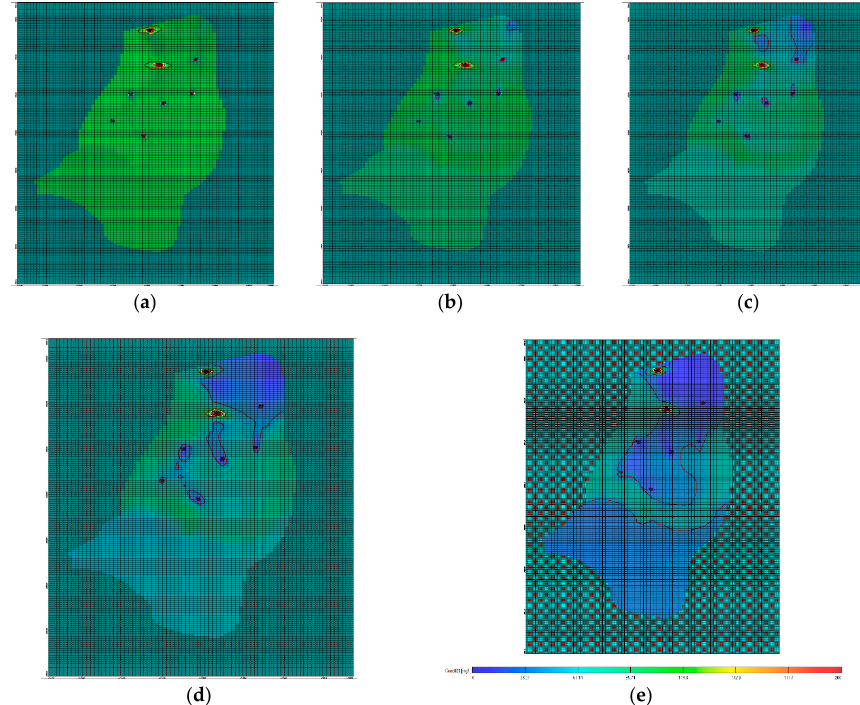
Figure 8. The MT3DMS model of the areal concentration of acesulfame after ( a ) 1 year, ( b ) 3 years, ( c ) 5 years, ( d ) 7 years, and ( e ) 10 years.